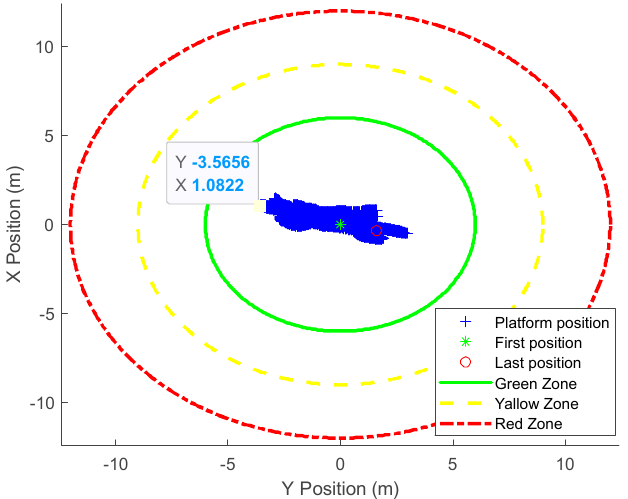
Figure 20. DP simulation with PID and PNN controls showing platform position (Beam sea).